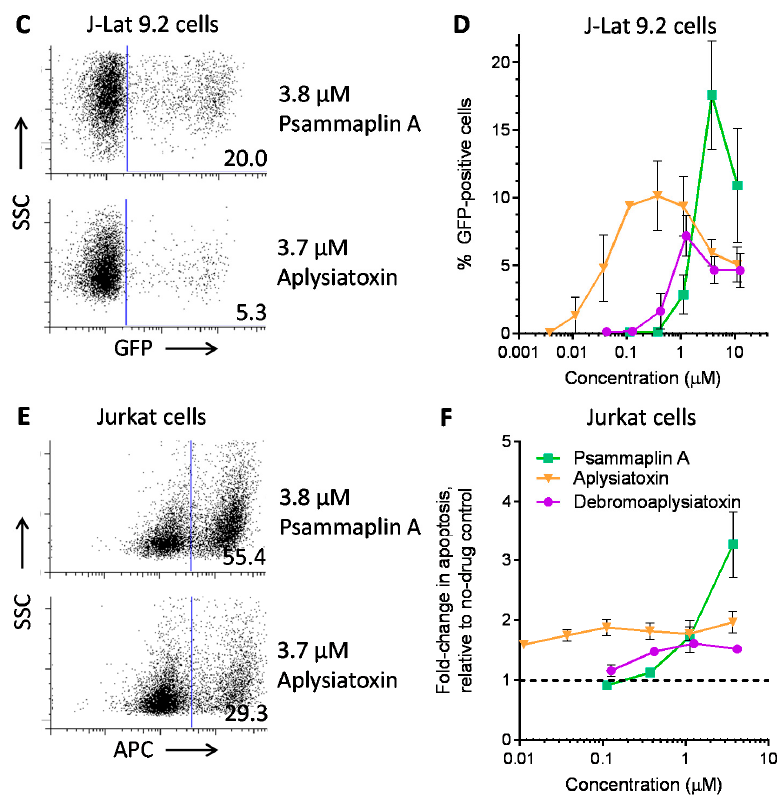
Figure 2. Discovery of new LRAs from marine natural products. ( A ) HIV latency reversal in J-Lat 9.2 cells, as assessed by measuring GFP reporter expression in the presence of 250 compounds from marine natural products at 2.5 µg/mL. Colored bars denote 4 of 250 compounds (1.6%) that induced GFP expression in at least 4% of cells (dotted line). ( B ) Structures of 4 LRAs identified from screening of 257 pure natural products at 2.5 µg/mL. Colors correspond to bars in panel A. ( C ) Representative GFP expression in J-Lat 9.2 cells treated with 3.8 µM psammaplin A (top) or 3.7 µM aplysiatoxin (bottom). Numbers to the right of the blue bar indicate percent GFP-positive (i.e., HIV-expressing) cells. ( D ) Effects of LRAs on HIV-1 provirus expression in J-Lat cells. ( E ) Representative effects of compounds on apoptosis in Jurkat cells, as measured by annexin V staining. Numbers to the right of the blue bar indicate percent APC-positive (i.e., apoptotic) cells. ( F ) Effects on apoptosis in Jurkat cells, expressed as fold-increase in apoptosis relative to control cultures treated with 0.1% DMSO (dotted line). Data presented in panels C and E originate from the same experiments shown in Figure 1A,C, respectively.